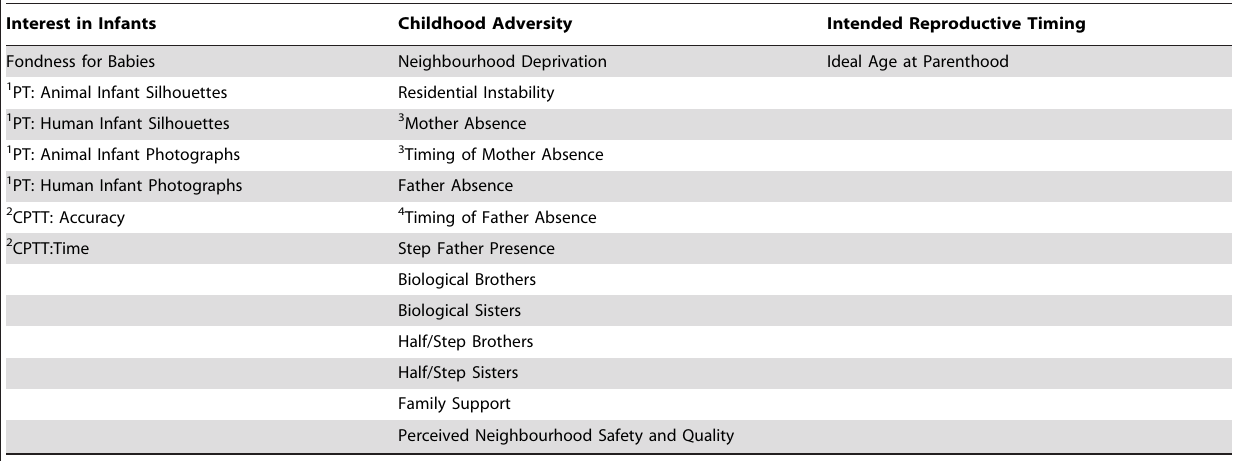
Table 1. Summary table of the study